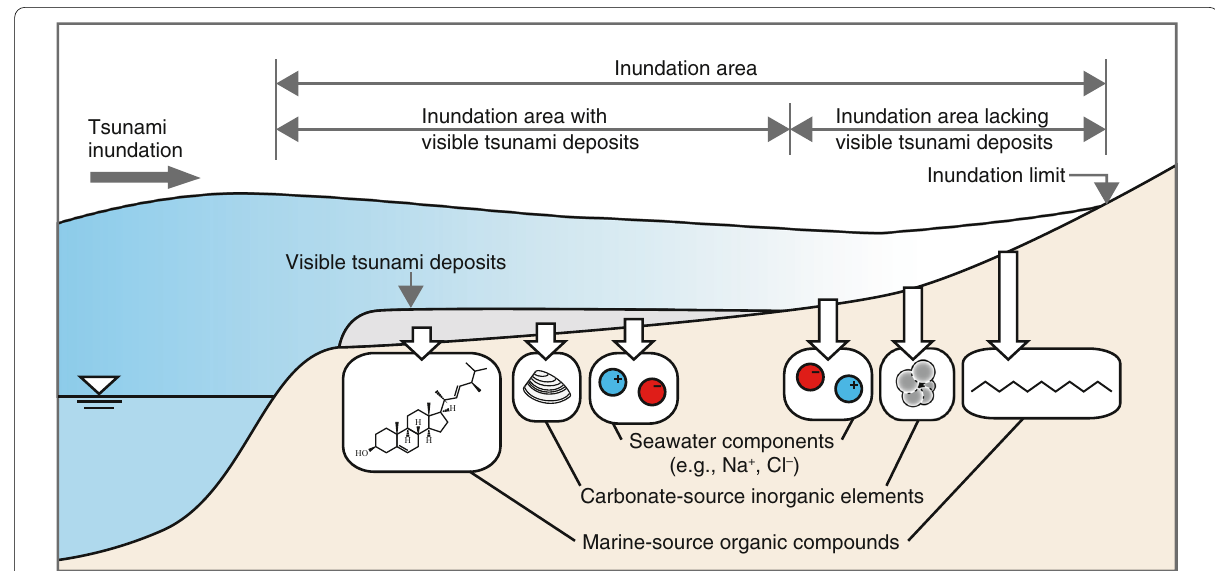
Fig. 2 Sedimentation and transportation by tsunami inundation. Tsunami deposits are not always deposited at the inundation limit; therefore, the inundation limit may be underestimated when considering only visible tsunami deposits. In contrast, geochemical signatures can be detected in both visible and invisible tsunami deposits because the signatures are derived from seawater